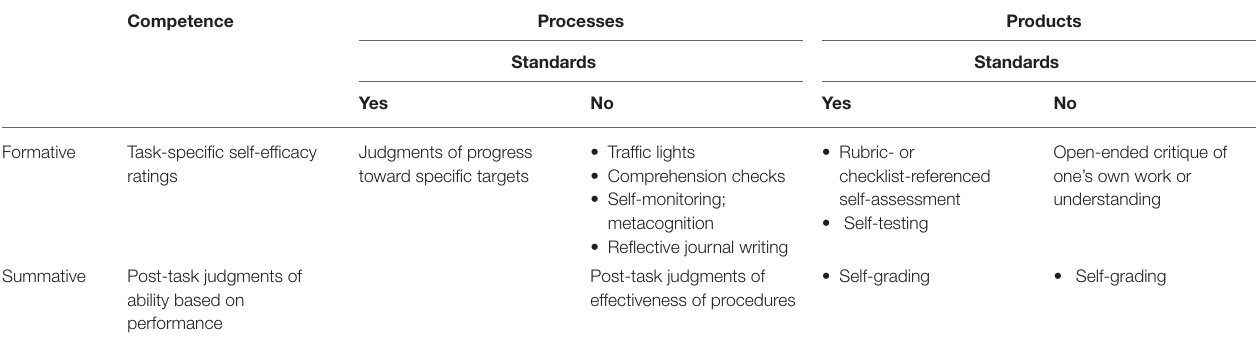
TABLE 1 | A taxonomy of